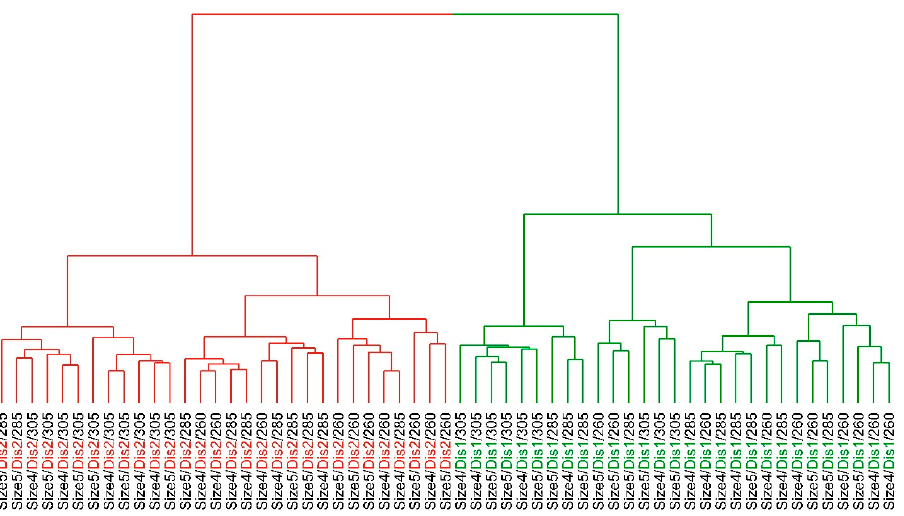
Figure 3. Dendrogram of subject 1, with distances highlighted in colors (Dis 1 = small distance; Dis 2 = far distance/free throw line). Ball sizes are indicated by their number (size 4 = small ball size; size 5 = big ball size); basket heights are labeled in cm (260/285/305).